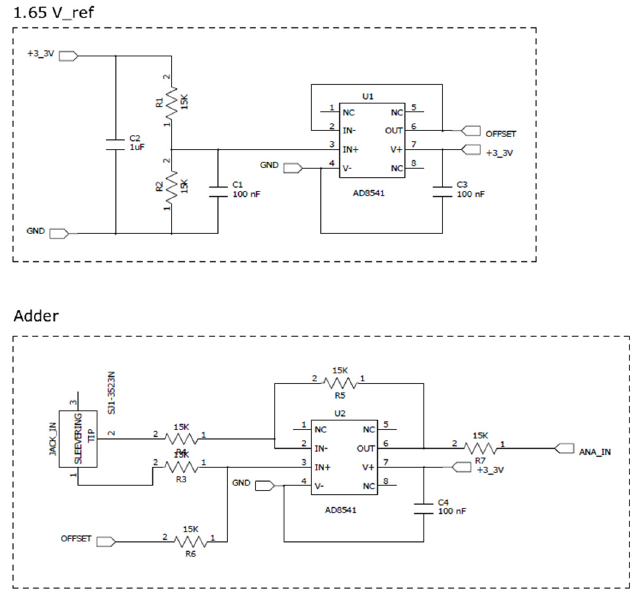
Figure 3. The schematic of signal conditioning circuit.